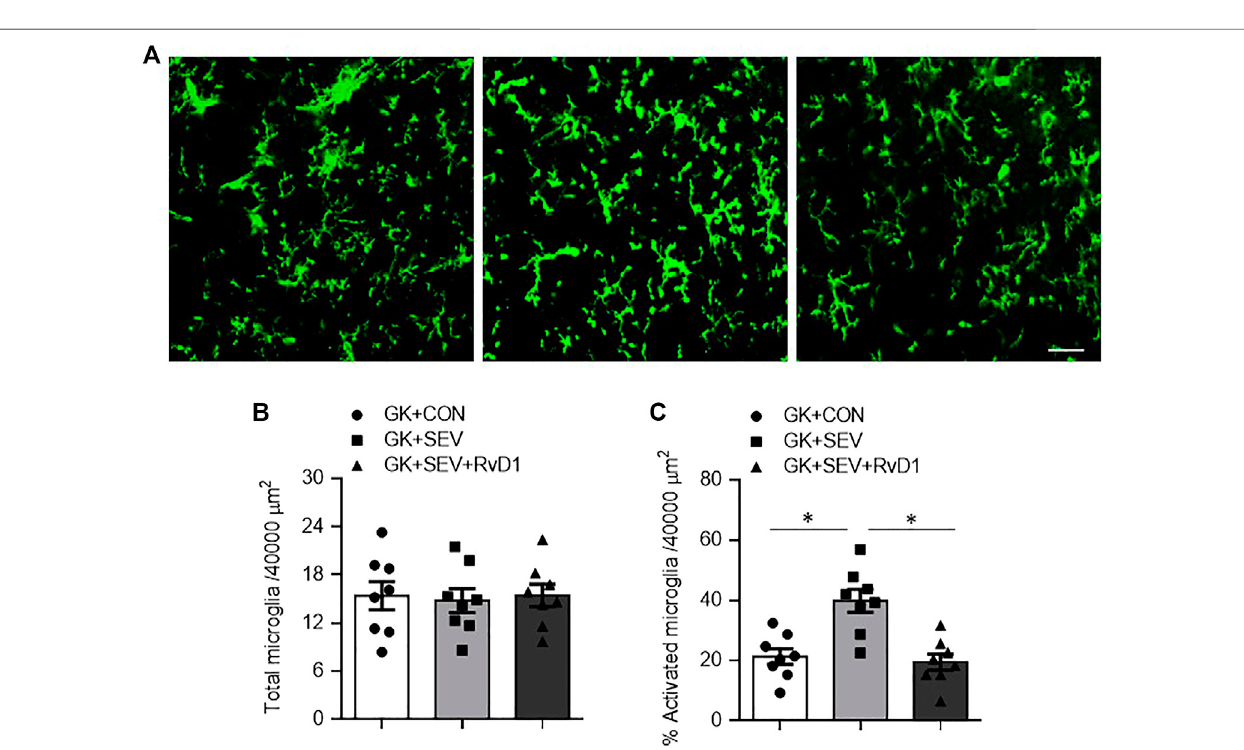
FIGURE 4 | Representative photomicrographs showing CD11b-immunoreactive microglia (A) and quantitative comparison of total (B) and activated (C) microglia intheinthehippocampusintype2diabeticGoto-Kakizaki(GK)ratsaftercontrol(CON)orsevo fl urane(SEV)exposureandinexogenousRvD1-treatedGKratsafterSEV exposure. Scale bar: 20 μ m. Data are presented as mean ± SE (n (cid:1) 8 for each group). * p < 0.05.